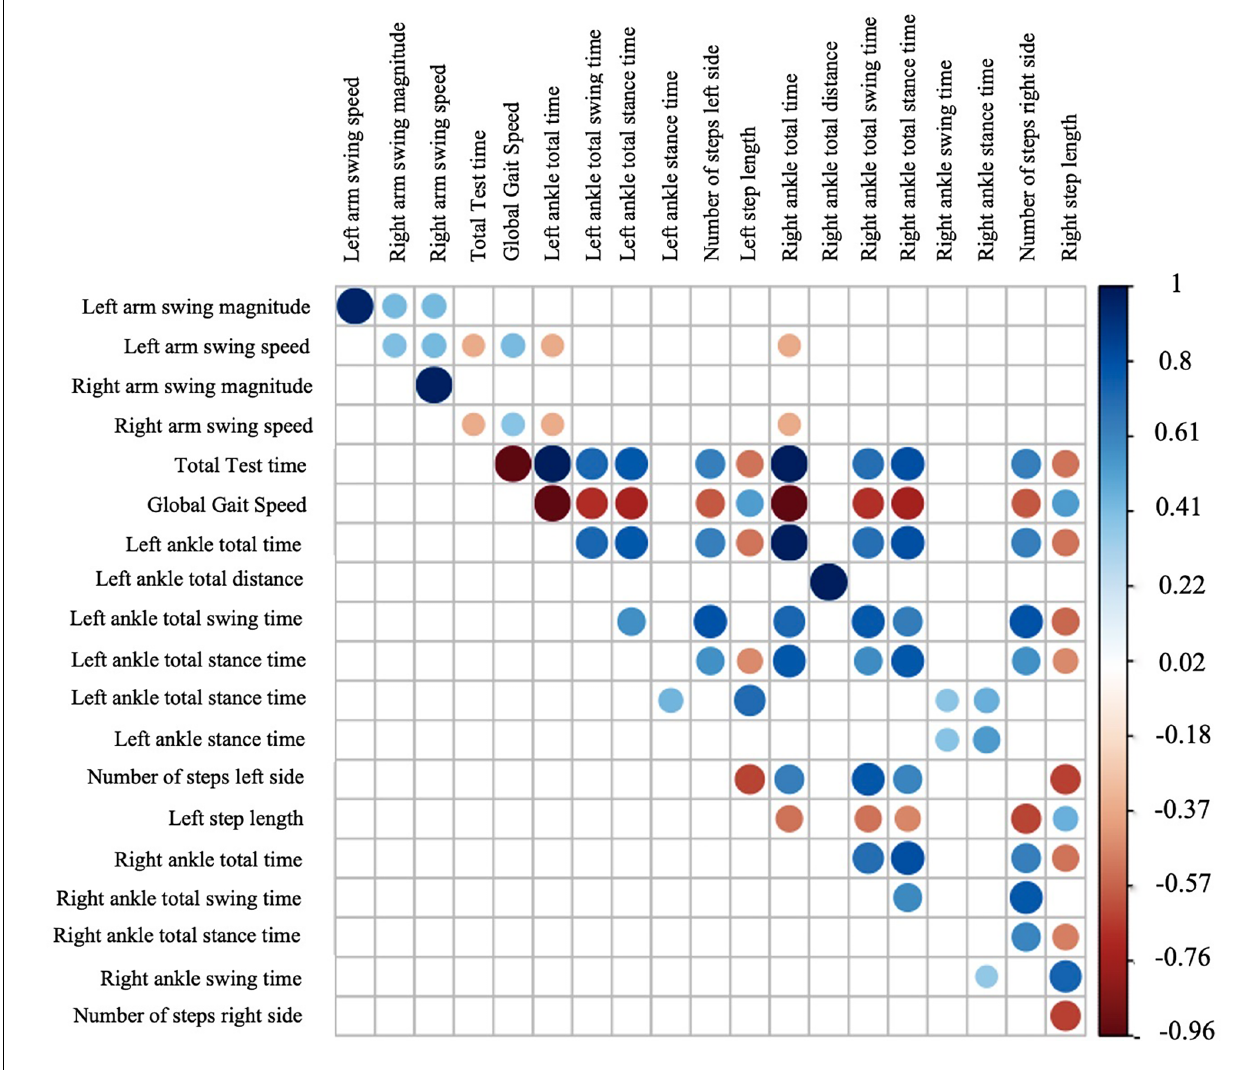
FIGURE 2 | Correlation matrix using gait